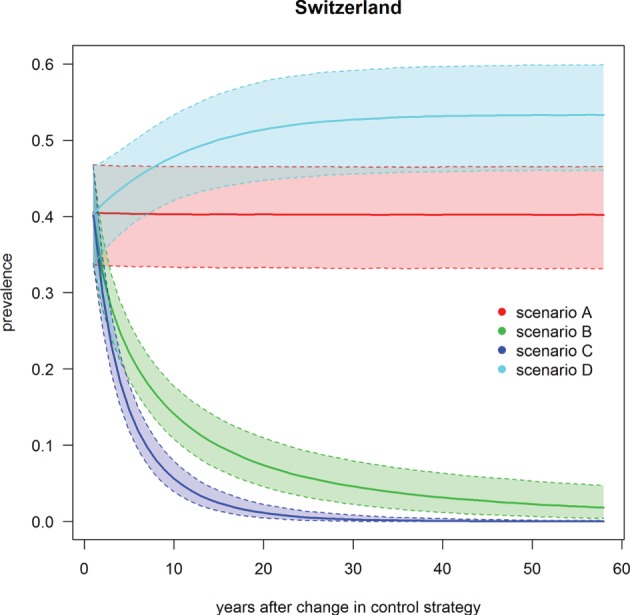
Trend of footrot prevalence for the four different scenarios A–D for entire Switzerland. Lower dashed line = 2.5‰, upper dashed line = 97.5‰, solid line = median out of 1,000 simulations.